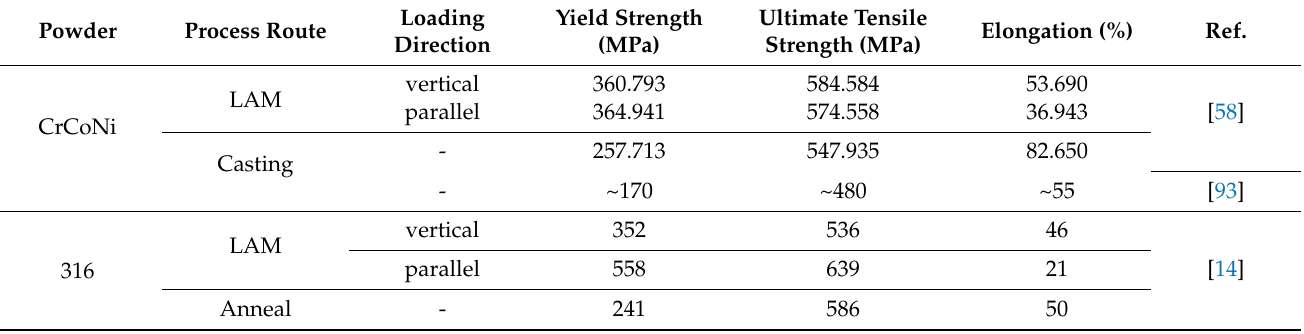
Table 3. Tensile properties of CrCoNi medium-entropy alloy and 316 samples of thin-wall fabricated by LMD and casting process in the vertical and parallel